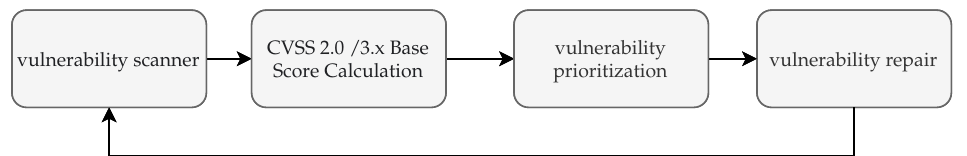
Figure 1. Model of the flow of information in the vulnerability management process with the base CVSS 2.0/3.x